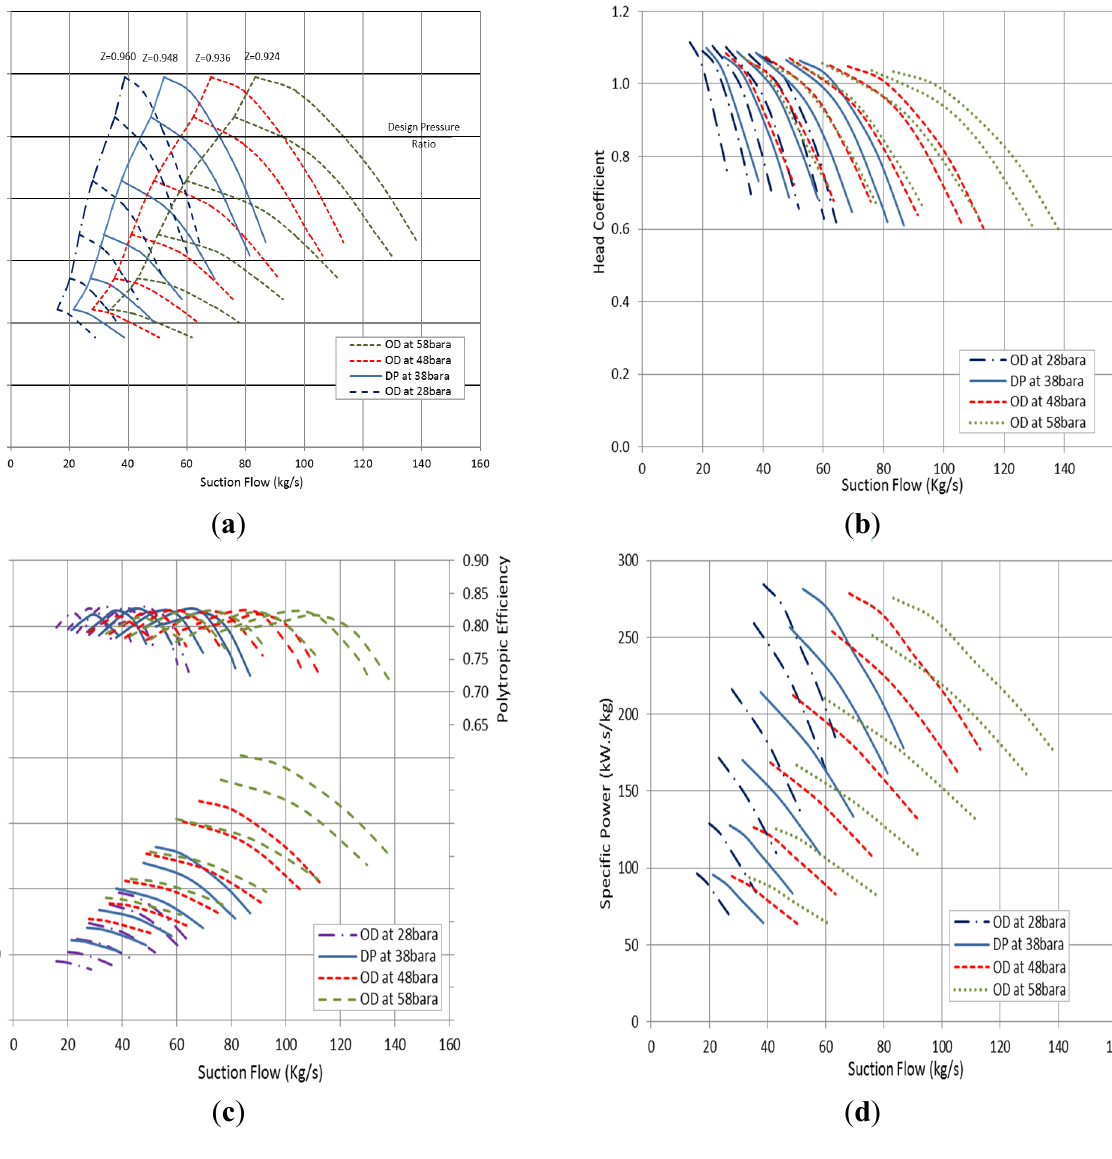
Figure 13. Effect of suction pressure on compressor performance parameters: ( a ) Pressure ratio; ( b ) Head coefficient; ( c ) Polytropic efficiency; ( d ) Specific